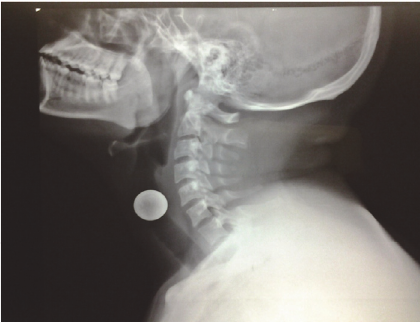
Figure 2: Lateral X-ray: lateral view showing rounded opacity in sagittal plane.